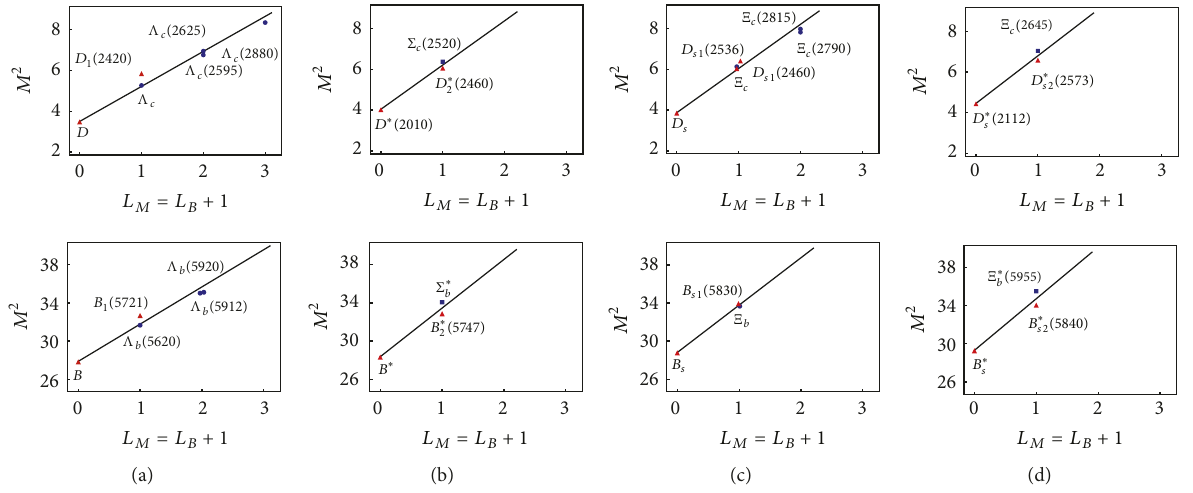
Figure 3: Trajectories for heavy-light hadrons with strongly broken conformal symmetry, from [14]. but conformal symmetry is strongly broken.